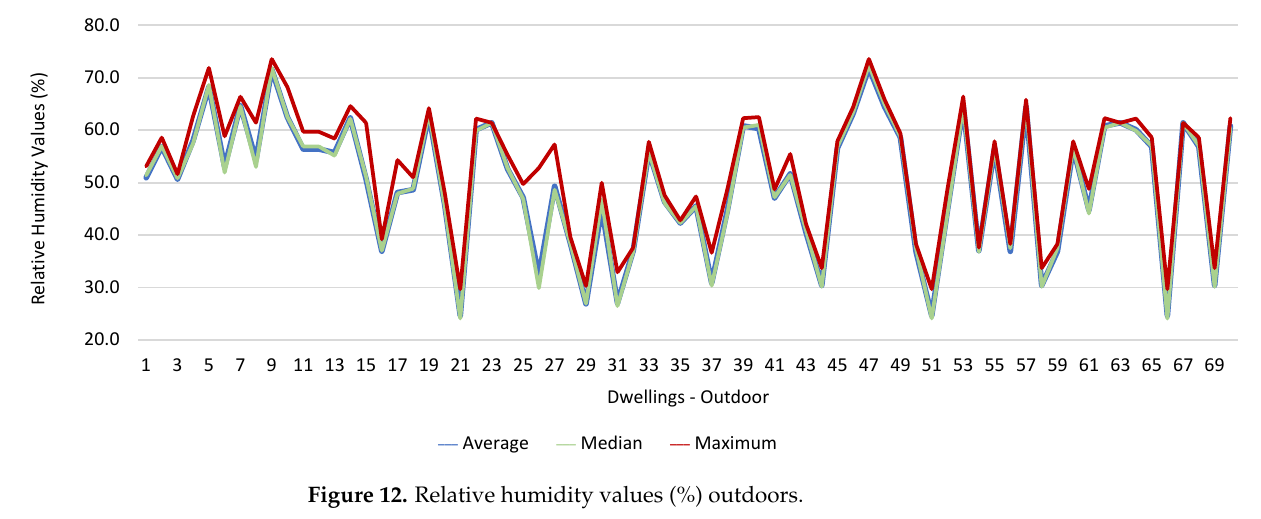
Figure 12. Relative humidity values (%) outdoors. For the environmental parameters that exceeded the protection threshold established in the legislation (CO 2 , CH 2 O, PM 2.5 , and PM 10 ), we also aimed to determine the areas of their residences in which the workers were at the greatest risk. Table 2 shows the ratio between the parameters that exceeded the protection thresholds and the geographic loca- tions of the workers’ homes. Table 2. Relationship between the parameters that exceeded the protection thresholds and the geo- graphic location of the workers’ homes .